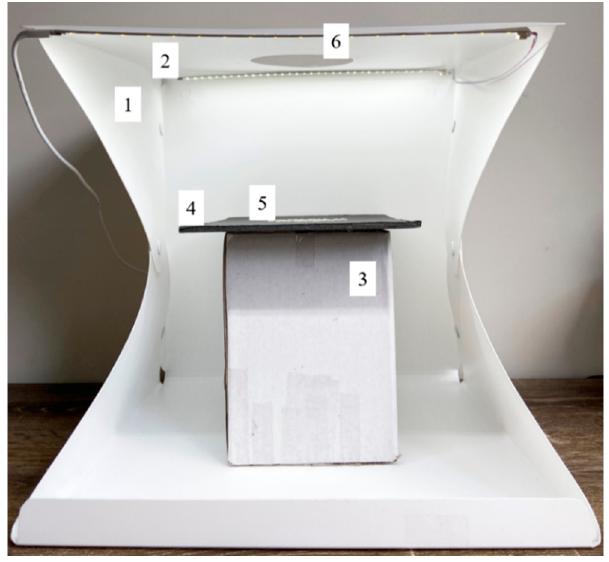
Figure 1. Experimental setup for image acquisition consisting of ( 1 ) a lightbox; ( 2 ) 70 pieces of two LED light strips; ( 3 ) a platform; ( 4 ) cardboard to place the grain for image acquisition; ( 5 ) rice samples; ( 6 ) top opening of the lightbox used to acquire the images using a smartphone. LED = light-emitting diode.